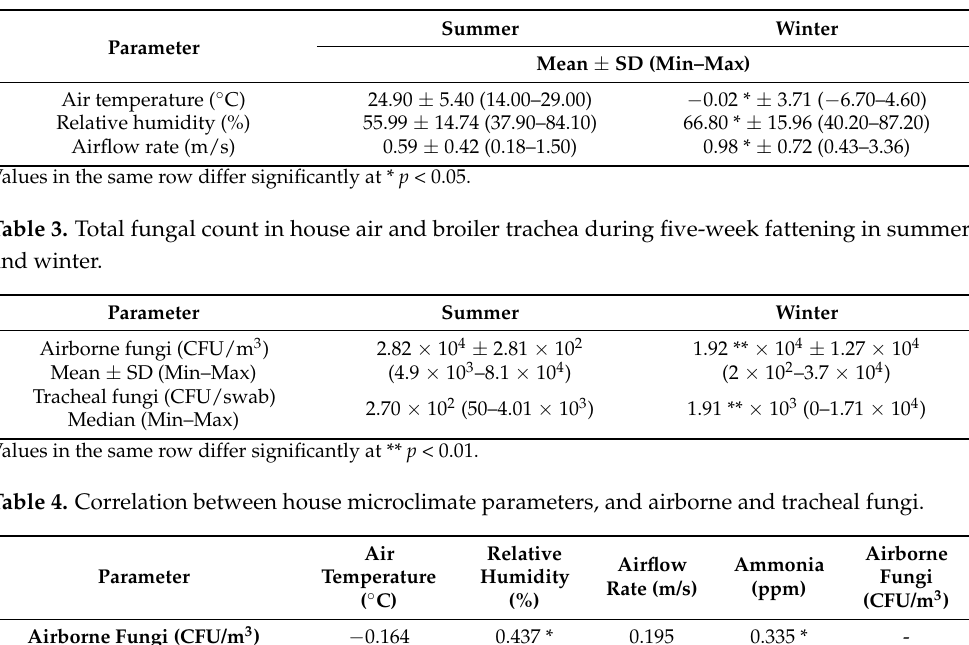
Table 2. Values of air temperature, relative humidity and airflow rate outside house during five- week broiler fattening in summer and winter.